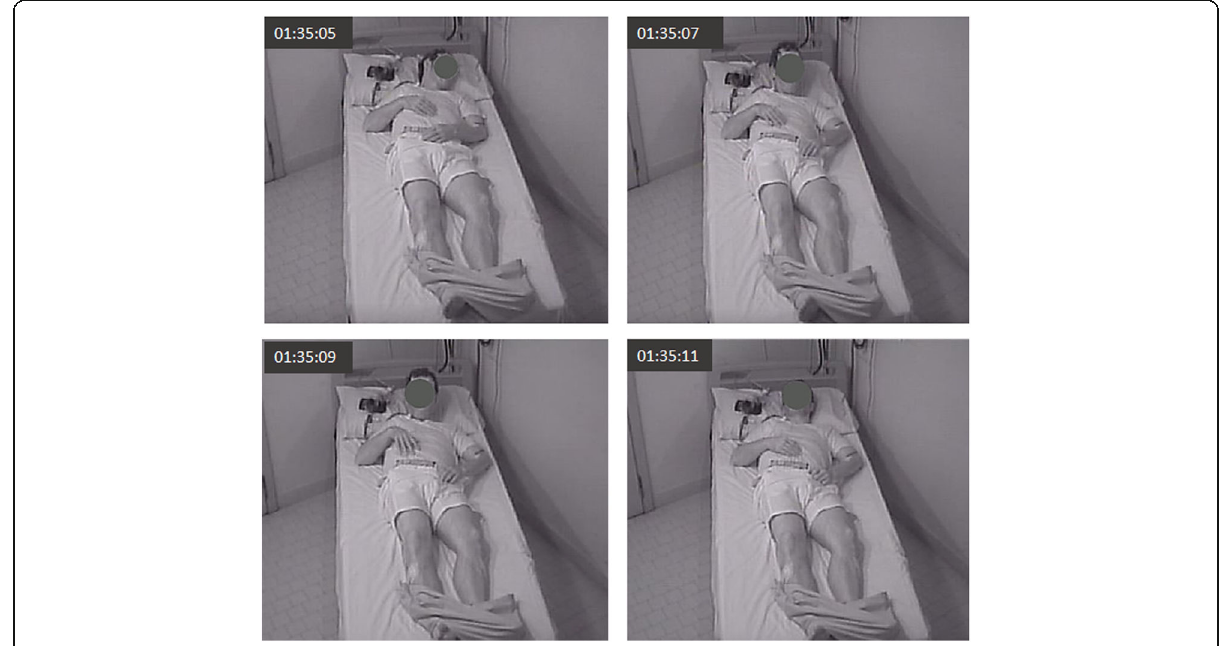
Fig. 3 Photographic sequences of a Simple Arousal Movement (SAM), pattern IA: head